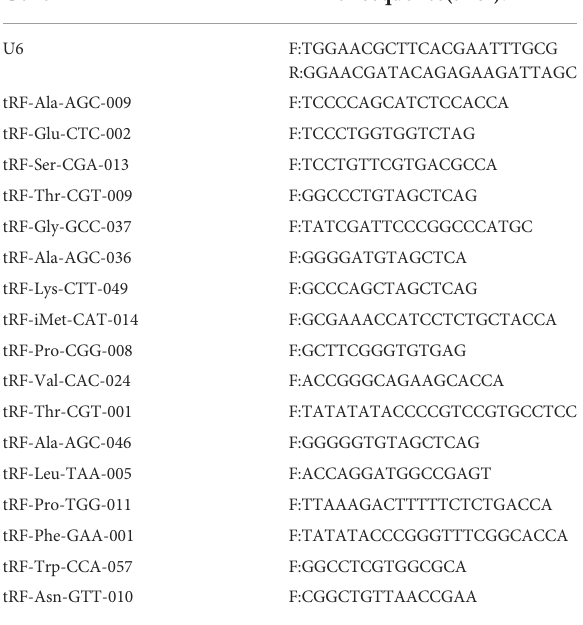
TABLE 2 | Primes seqence